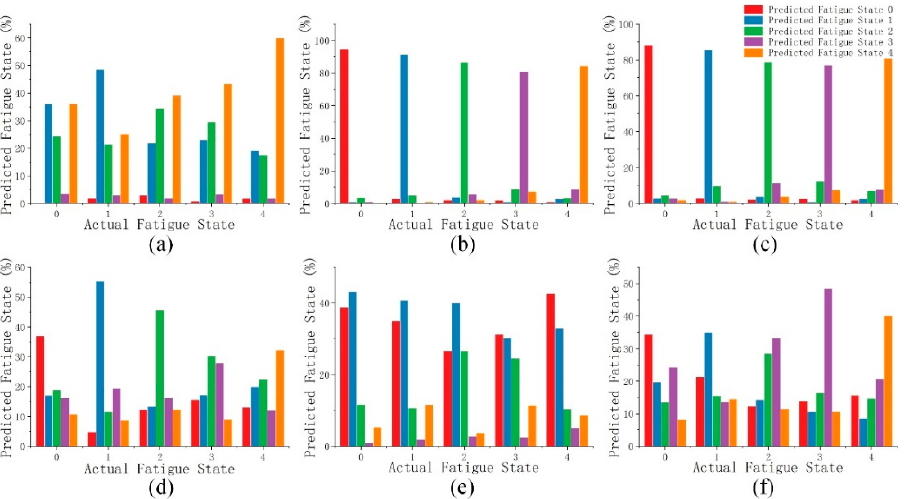
Figure 8. ( a ) Logistic regression prediction results. ( b ) Random forest prediction results. ( c ) GBDT prediction results. ( d ) SVM RBF prediction results. ( e ) SVM linear prediction results. ( f ) SVM poly prediction results.